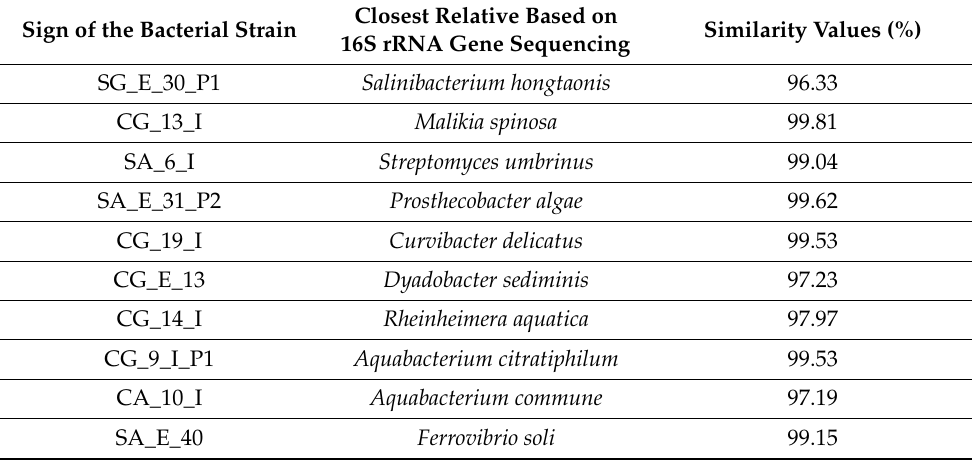
Table 3. The list of bacteria able to grow only in nutrient-depleted conditions. Sign of the Bacterial Strain